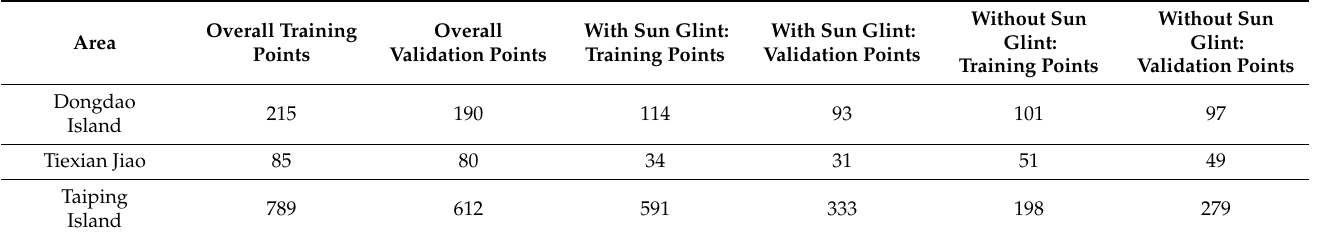
Table 2. The number of water depth training points and validation